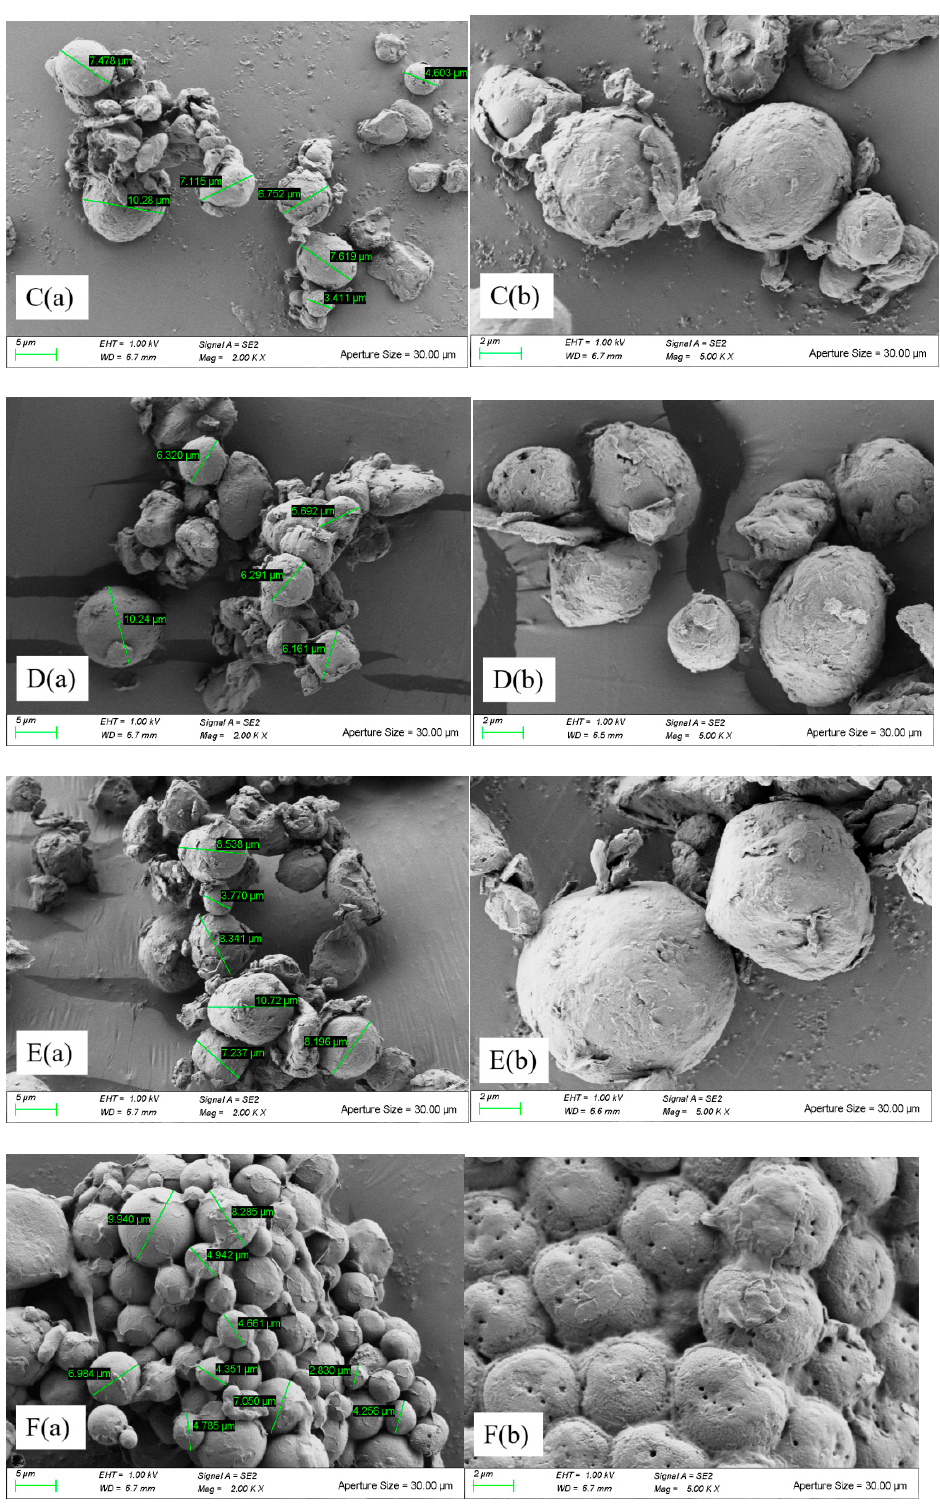
Figure 2. Scanning electron microscopy observation of different Tartary buckwheat flour via airflow ultrafine-grinding at different grinding pressures. (Tartary buckwheat ultrafinemilled flour No. 1 ( A ); Tartary buckwheat ultrafinemilled flour No. 2 ( B ); Tartary buckwheat ultrafinemilled flour No. 3 ( C ); Tartary buckwheat ultrafinemilled flour No. 4 ( D ); Tartary buckwheat ultrafinemilled flour No. 5 ( E ); Tartary buckwheat common flour No. 6 ( F ); ( a ) is magnified 2000 times and ( b ) 5000 times.)